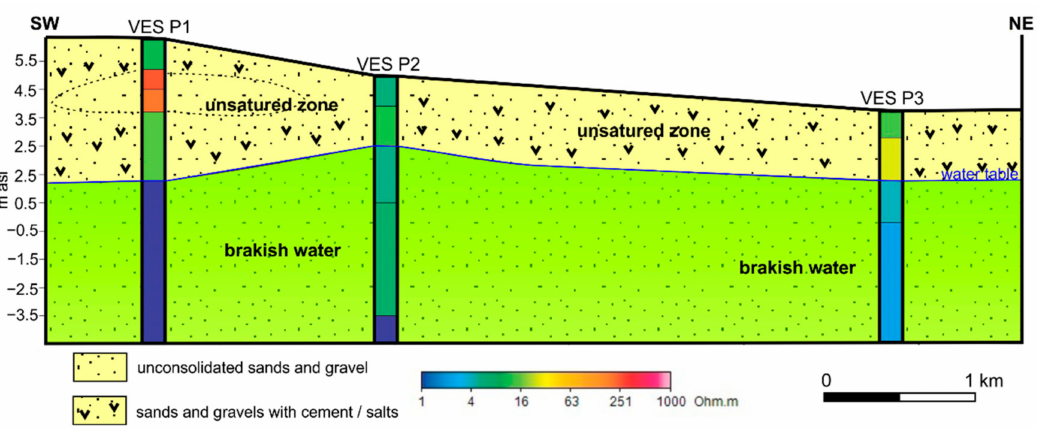
Figure 3. Vertical electric soundings of Pleistocene beach ridges.